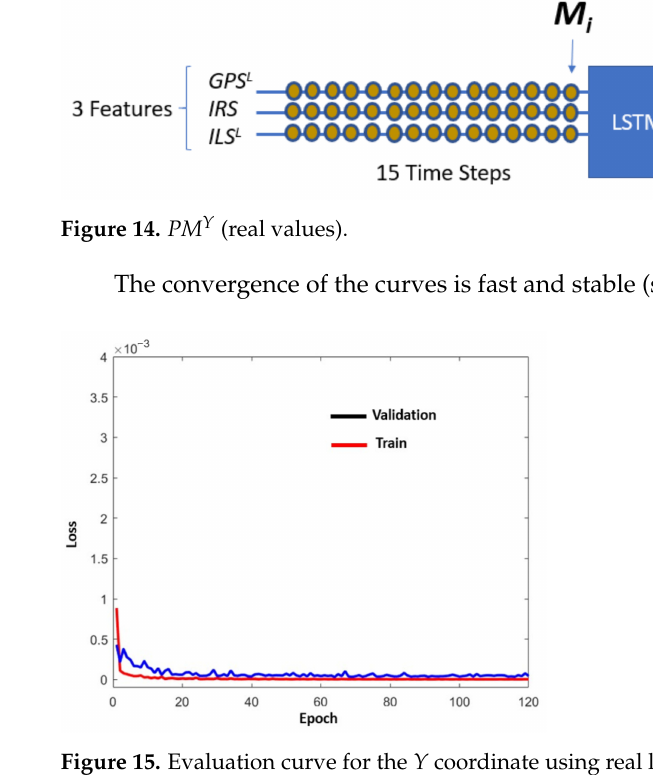
Figure 15. Evaluation curve for the Y coordinate using real landing values.